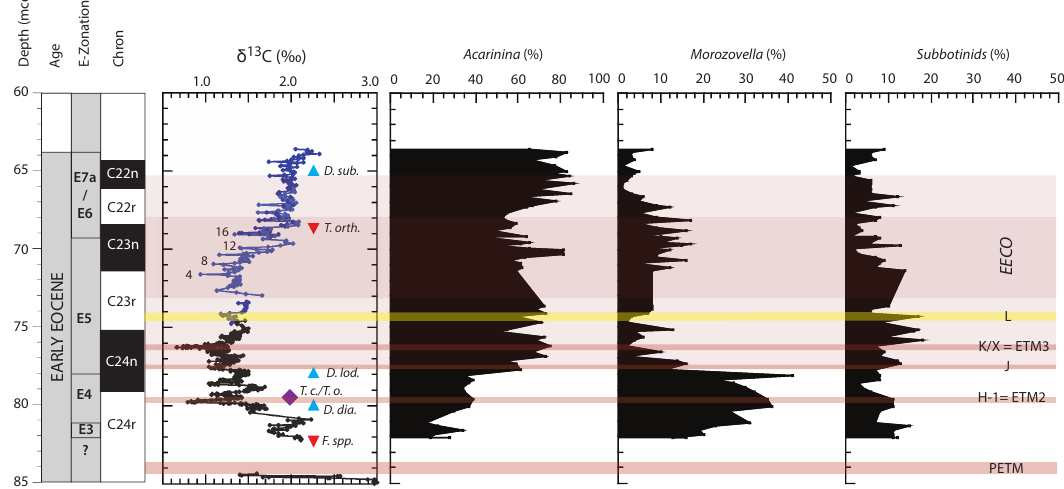
Figure 7. The early Eocene succession at DSDP Site 577 and its δ 13 C record (Fig. 5) with relative abundances of primary planktic foraminiferal genera (Lu, 1995; Lu and Keller, 1995). Note that the major switch in Morozovella and Acarinina abundances approximately coincides with the J event, the top of polarity Chron C24n and the start of the EECO. Calcareous nannofossil horizons are the same as in previous figures. Early Eocene events are the same as those in Fig. 4.